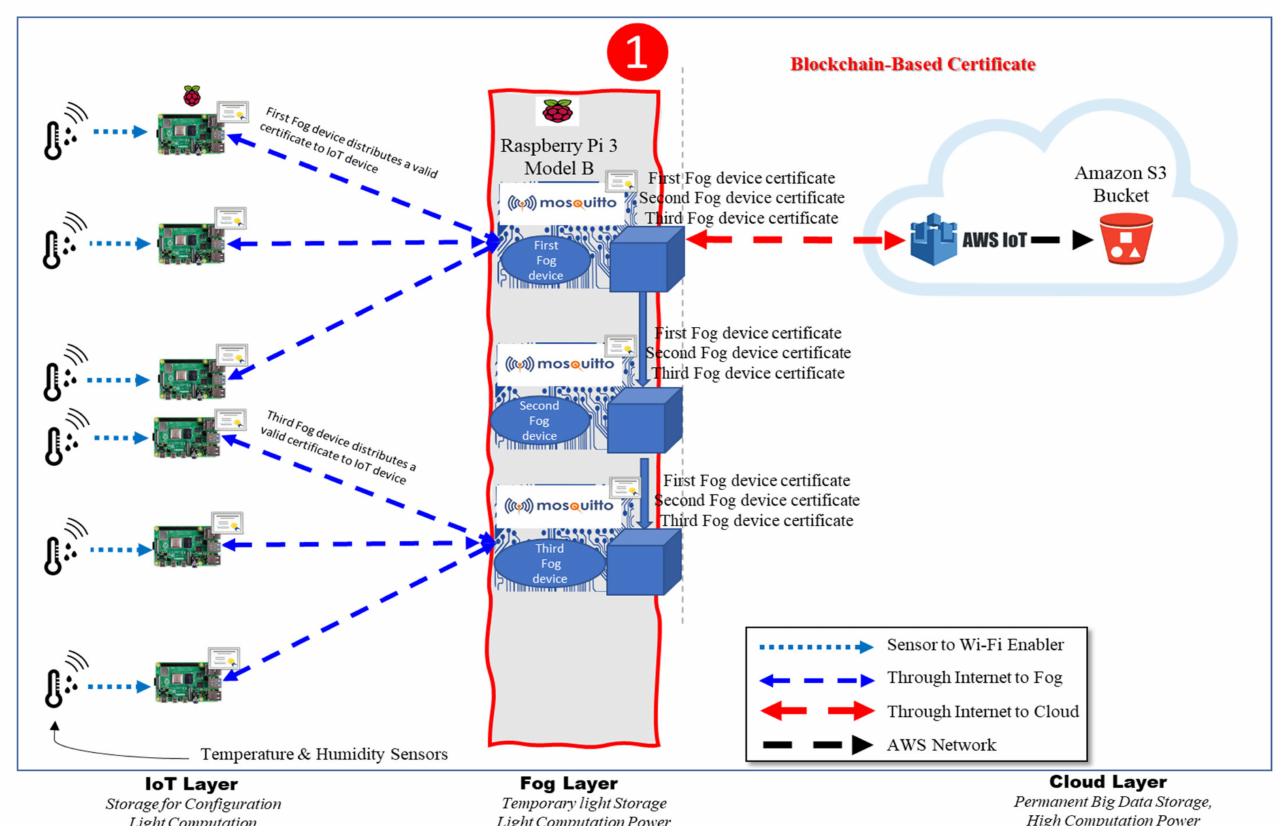
Figure 2. Blockchain-based certificate model applied to the IoT–Fog–Cloud